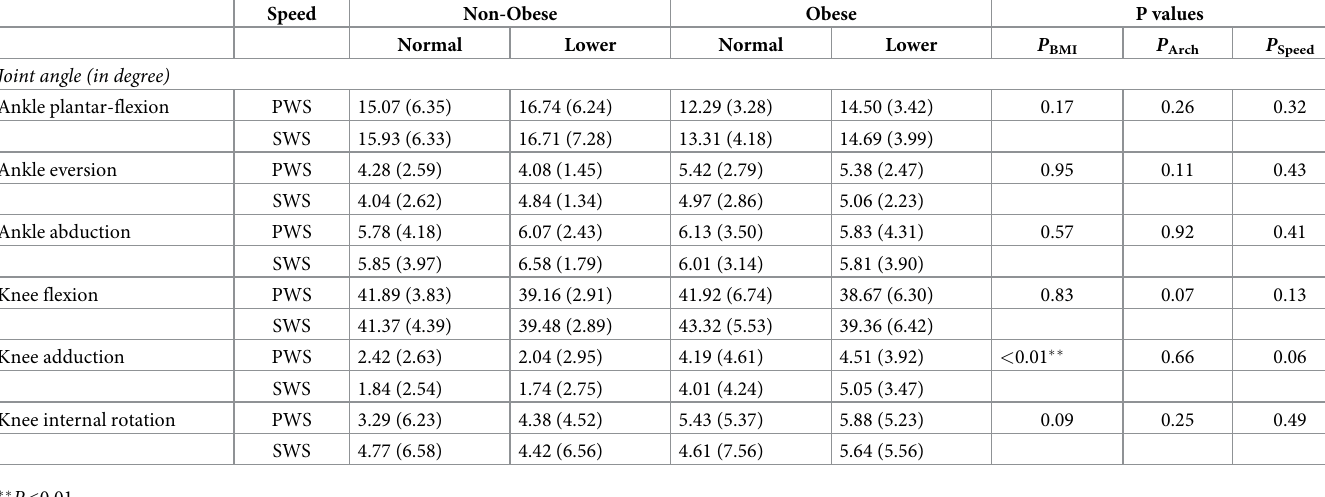
preferred and standard walking speeds, the direction of the foot progression was significantly different between arch groups; the foot progression angle was positive (i.e., in-toeing) in the lower arch group versus negative (i.e., out-toeing) in the normal arch group (Table 2). Lower-limb joint kinematic and kinetic measures For kinematic measures at the ankle and knee joints, there was a statistically significant effect of BMI on a knee adduction angle, F (1,43) = 38.18, p < 0.01, η p 2 = 0.47, while all other simple main effects were not statistically significant ( ps > 0.05; Table 3). The knee adduction angle was Table 3. Means (standard deviations) for lower-limb joint angles during walking at each participant’s preferred walking speed (PWS) and pedestrian standard walking speed (SWS), 1.25 m/s, across BMI (non-obese and obese) and arch (normal arch and lower arch) groups. Statistical results using three-way mixed ANOVA are also shown ( P BMI : P values of BMI effect; P Arch : P values of arch height effect; P Speed : P values of speed